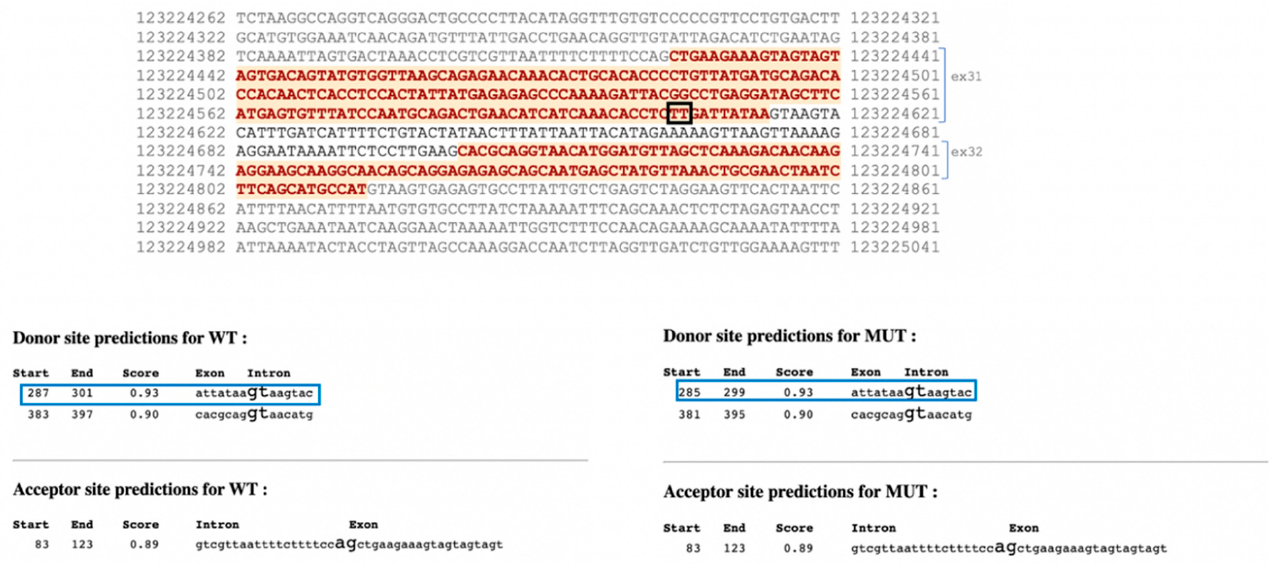
Figure 3. Top: Exon-intron sequences 31 and 32 of the STAG2 gene. The coding regions are indicated